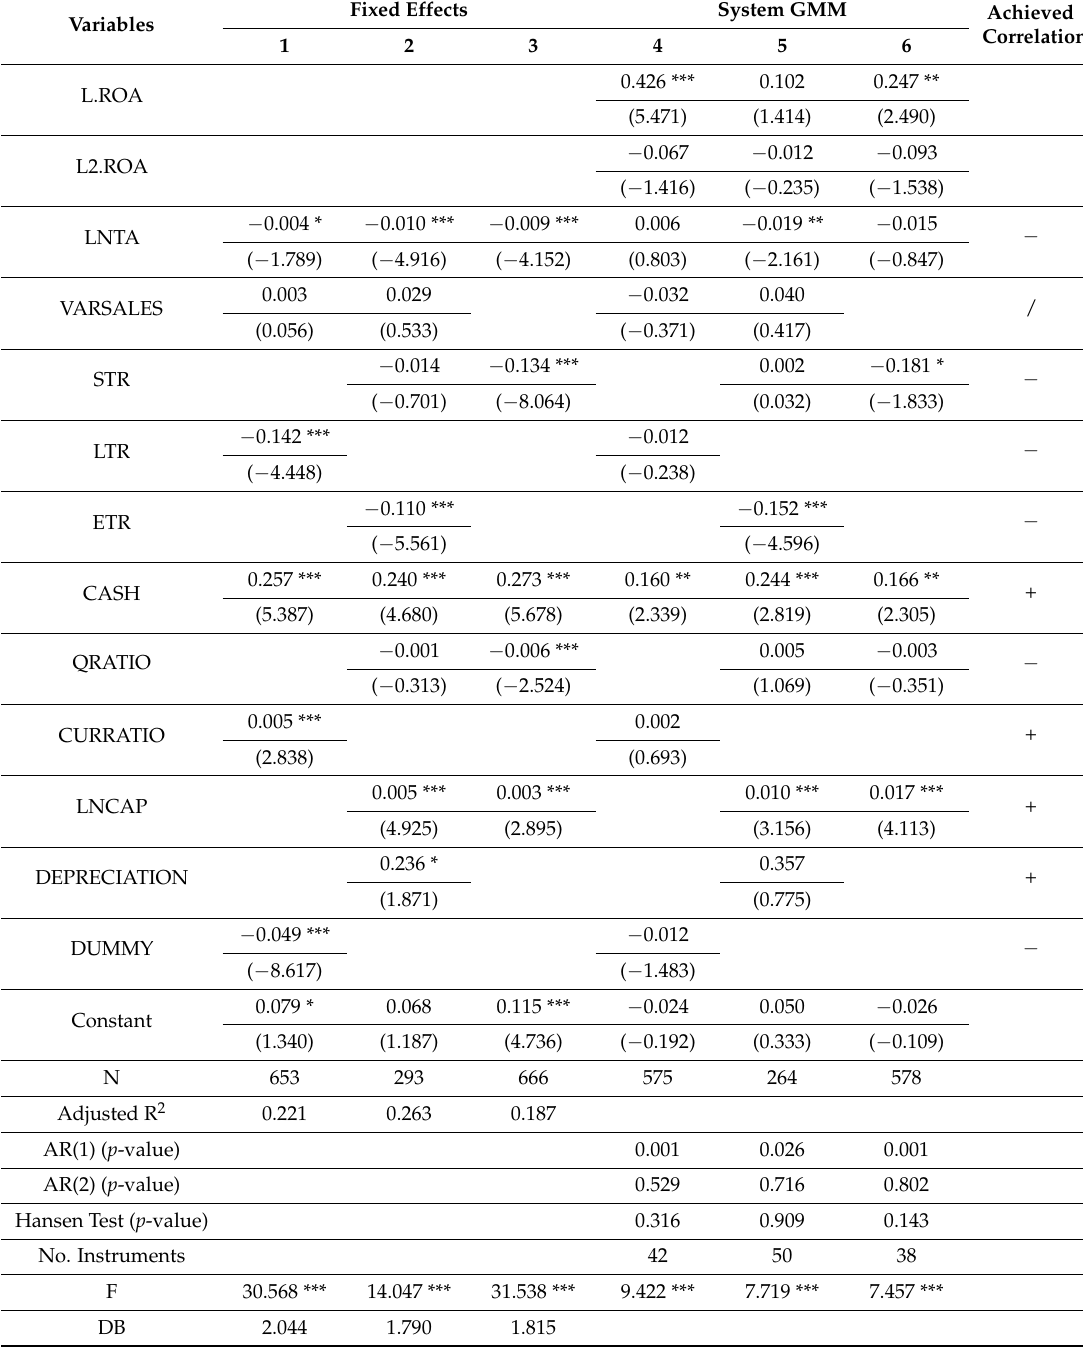
Table 9. Econometric results—dependent variable